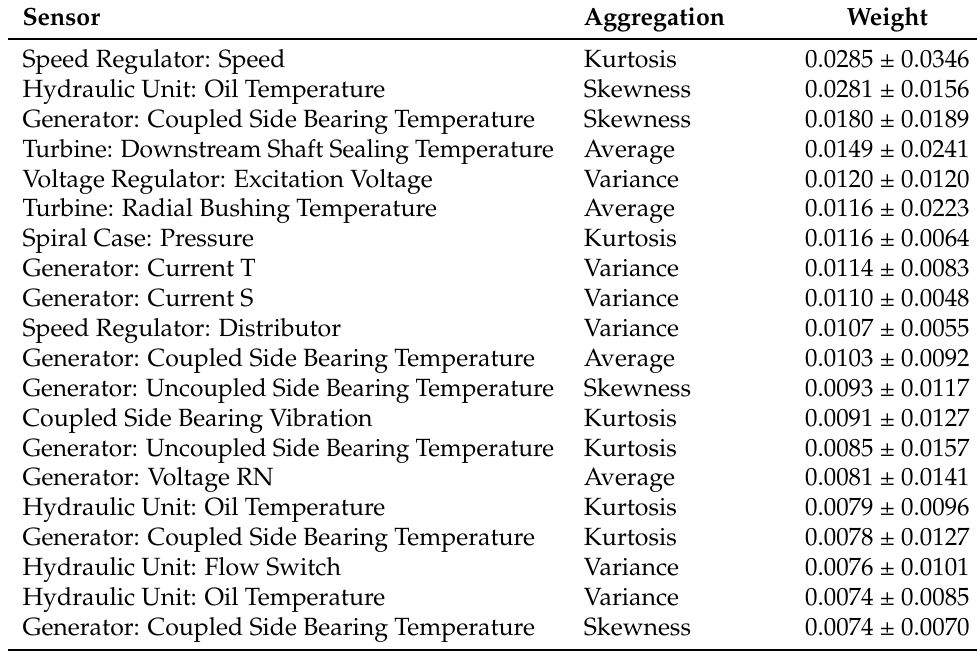
Table 6. The 20 most important features of HOS-RSF using permutation importance. Column weight represents the average increase in the C-index when the feature is available.